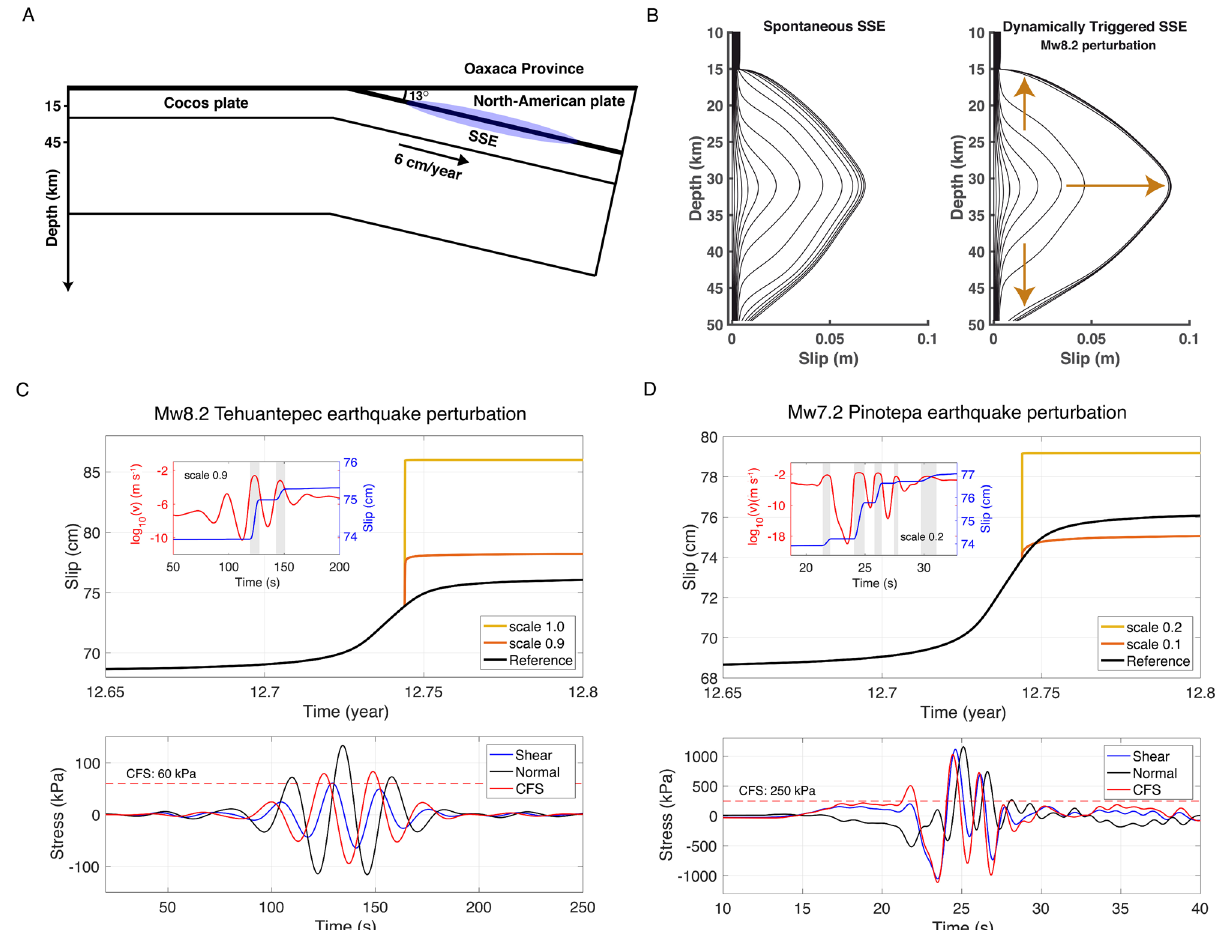
Fig. 7 Rate-and-state fault models for SSE triggering by seismic-wave stress perturbations. A Synoptic 2D model of the subduction zone in the study area. B Slip evolution of a spontaneous SSE and a dynamically triggered SSE in the R&S friction model subject to the Mw8.2 Tehuantepec earthquake stress perturbations estimated under the YOIG station (Fig. 6A and Supplementary Fig. 9). The contours time increment is about 2 days. C Top, slip evolution of the SSE reference model, and two triggered events at 31 km depth for stress perturbations due to the Mw8.2 Tehuantepec earthquake with different scaling factors. The inset shows the slip velocity and slip at that depth for the 0.9 scaled perturbation. Bottom, unscaled stress perturbation used in these simulations. D the Same as C but for the Mw7.2 Pinotepa earthquake. Please note that the scaling factors are